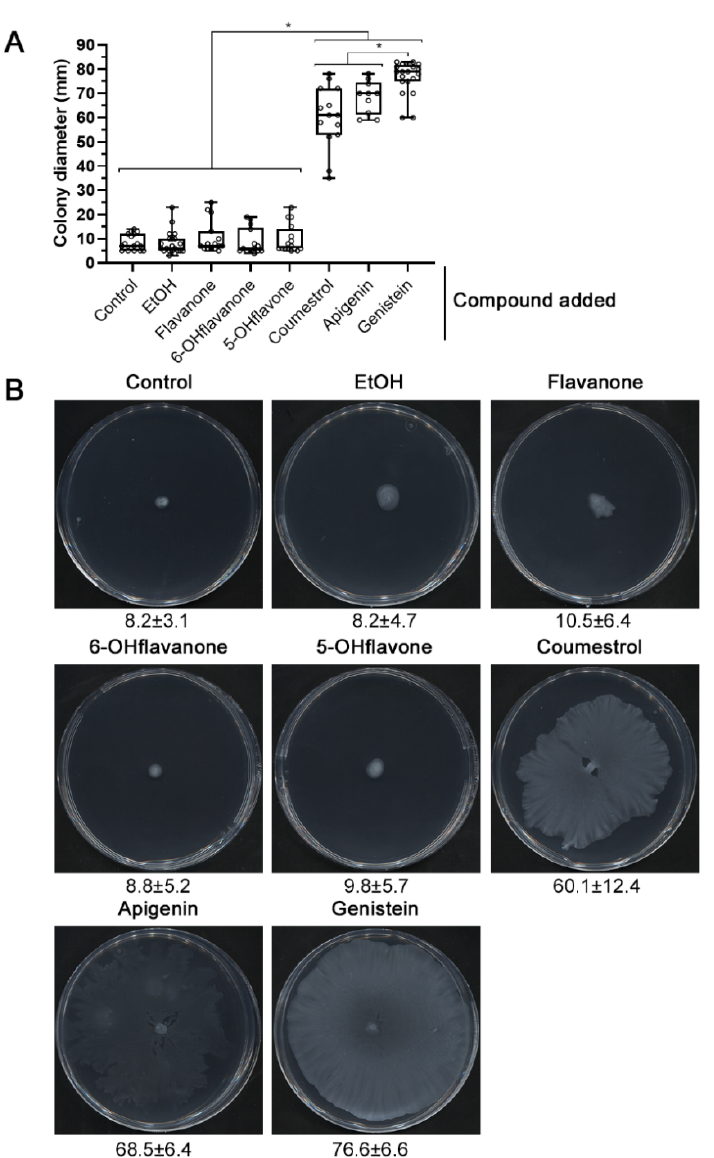
Figure 1. Effect of different compounds (including nod gene-inducing and non-inducing flavonoids) on S. fredii HH103 surface motility. Surface motility experiments were performed on minimal medium (MM) using 0.4% agarose as the gelling agent and scored at 72 h. ( A ). Box and whisker plots from at least three biological replicates performed with three technical replicates. Asterisks (*) indicate significant differences with the corresponding control sample using the non-parametric test of Mann–Whitney, α = 1%. ( B ). Representative pictures of the motilities exhibited by S. fredii HH103 under each condition. Values under images represent the average and standard deviation of surface migration (given in millimetres and determined as described in the text).